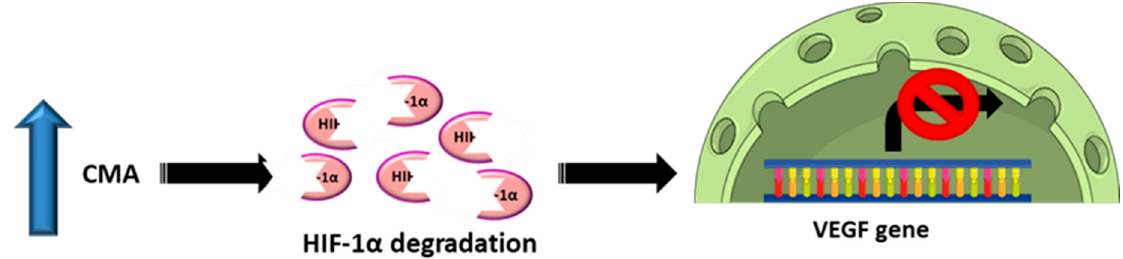
Figure 6. Schematic representation of our hypothesis connecting the regulation of VEGF expression and chaperone-mediated autophagy (CMA) activity.